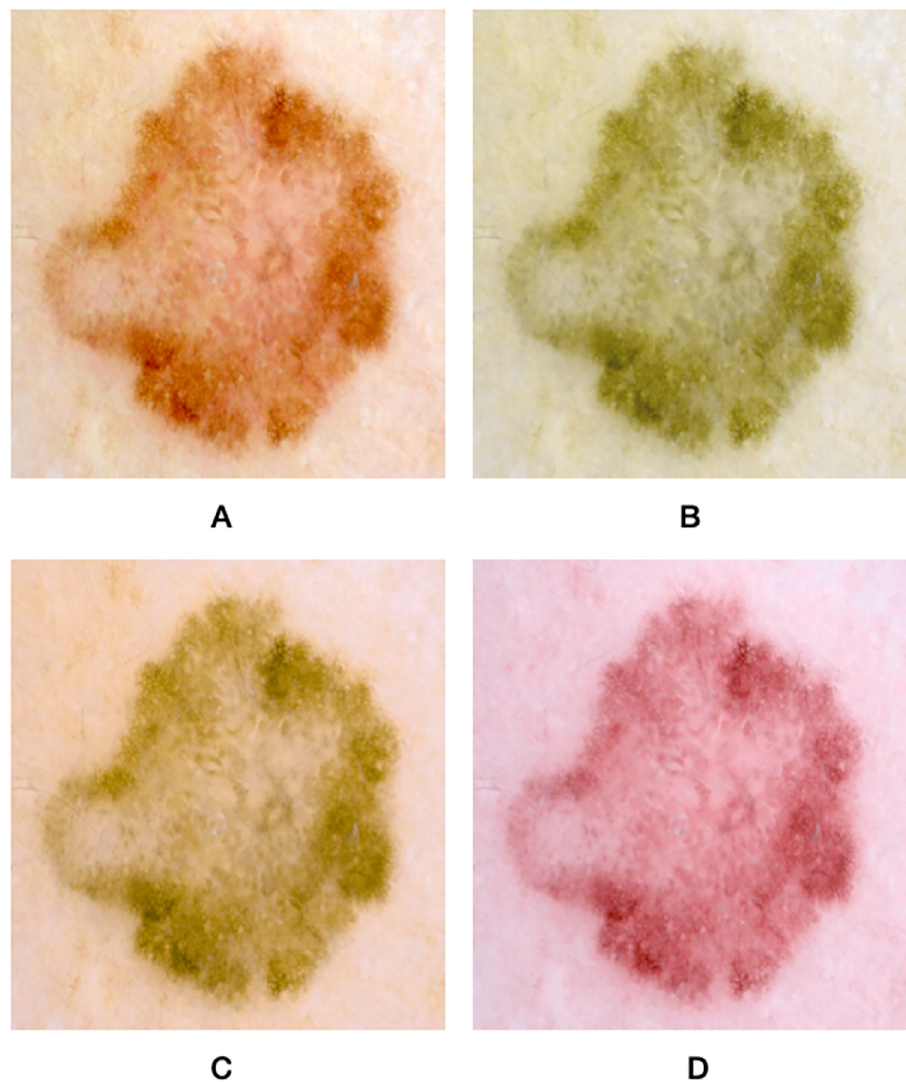
Fig 2. A melanoma presented as an example of a malignant skin lesion (A) simulated into what a protanope (B), deuteranope (C), and tritanope (D) participant would see. The image presented here is not a part of the MED-NODE database. Figure adapted from Longo et al. study (non-simulated image)